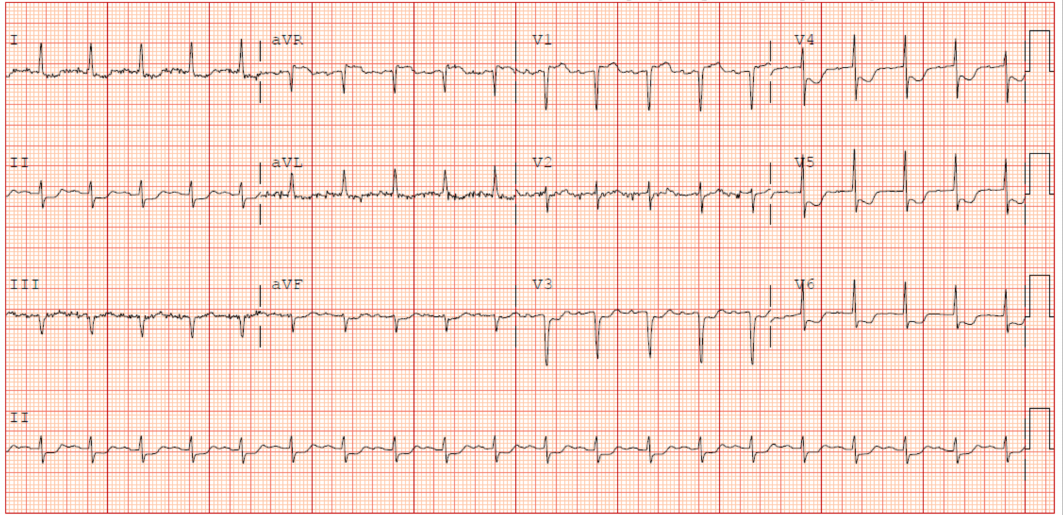
Figure 1. Initial EKG on presentation to the ED demonstrating diffuse ST segment depressions.